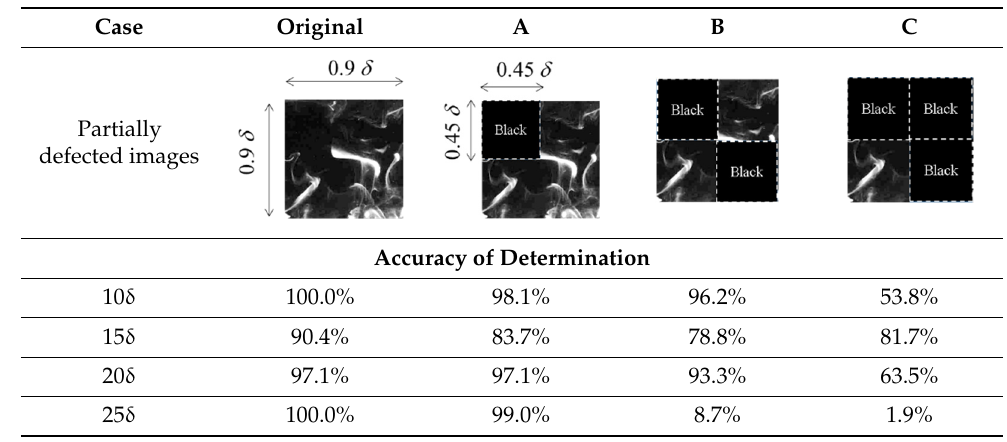
Table 2. Accuracy of determination for partially defected images. N d = 416 for each case.